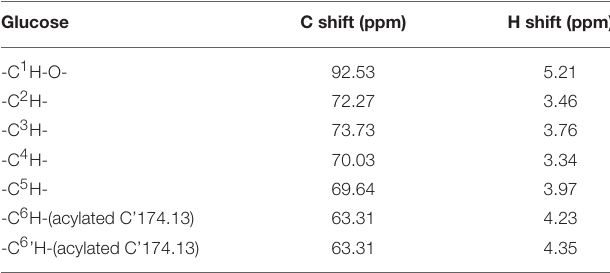
TABLE 4 | Chemical shifts of the main product, presented in the purified, and fractionated sample of a synthesis reaction of vinyl octanoate in honey with an immobilized